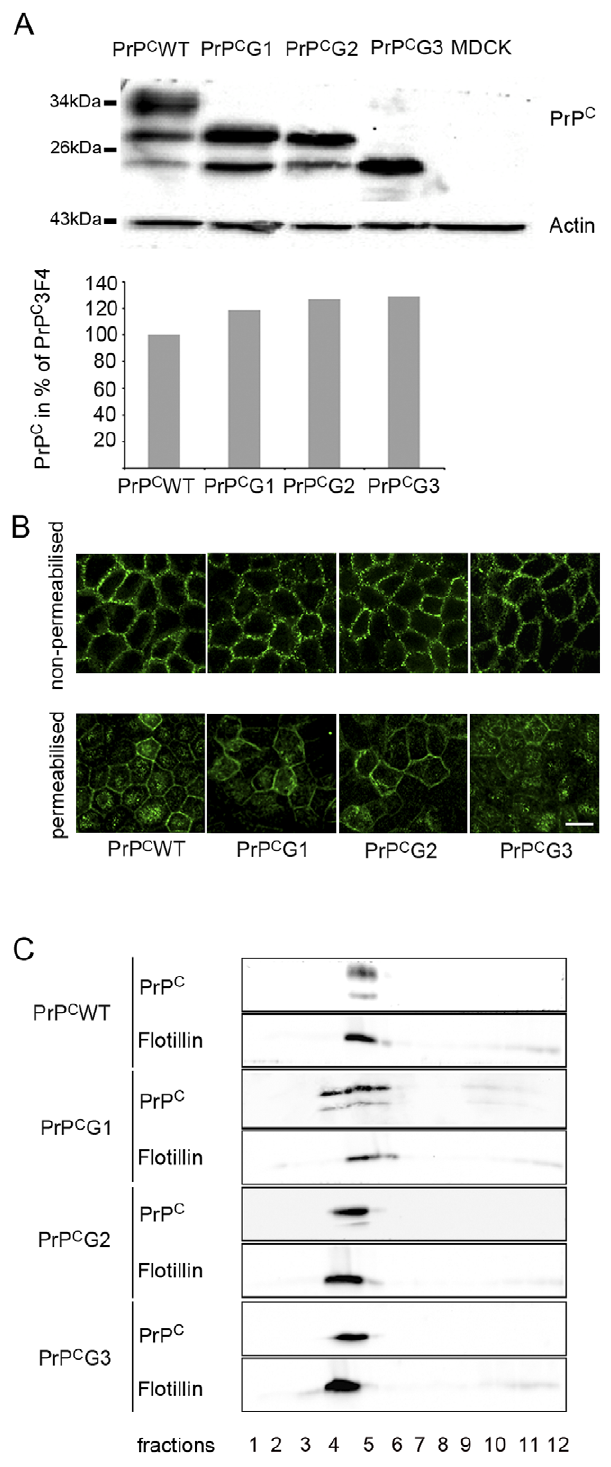
Figure 2. Physiological membrane localization of PrP C glyco- mutants. (A) Characterization of glycomutants (PrP C G1, PrP C G2, and PrP C G3) and PrP C WT for the study by Western blot analysis, using an antibody directed against the 3F4 epitope. Clones with similar amounts of overexpressed 3F4 tagged PrP C as assessed by densitometric analysis of Western blots were used for these analyses (see graph). Relative expression of various PrP C forms is shown in percentages of PrP C WT that was set to 100%. (B) Assessment of plasma membrane (non- permeabilized) and intracellular (permeabilized) localization of PrP C